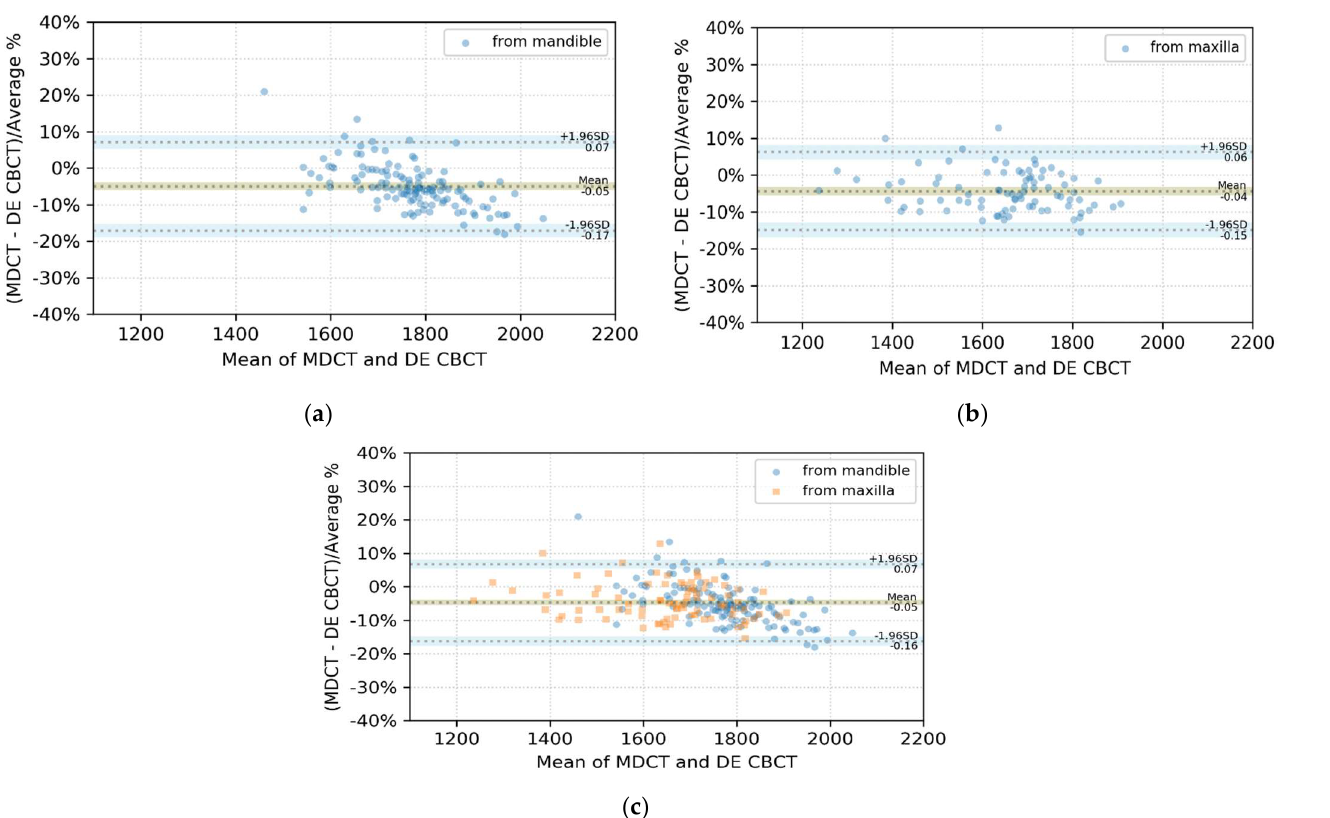
Figure 6. BA plots of the differences between paired ROI means of MDCT and DE-CBCT, expressed as percentages of the